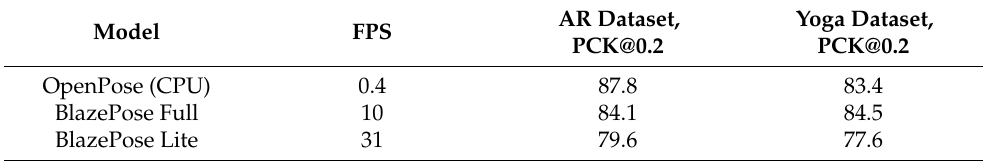
Table 2. Frame rate comparison between OpenPose and MediaPipe with AR dataset.